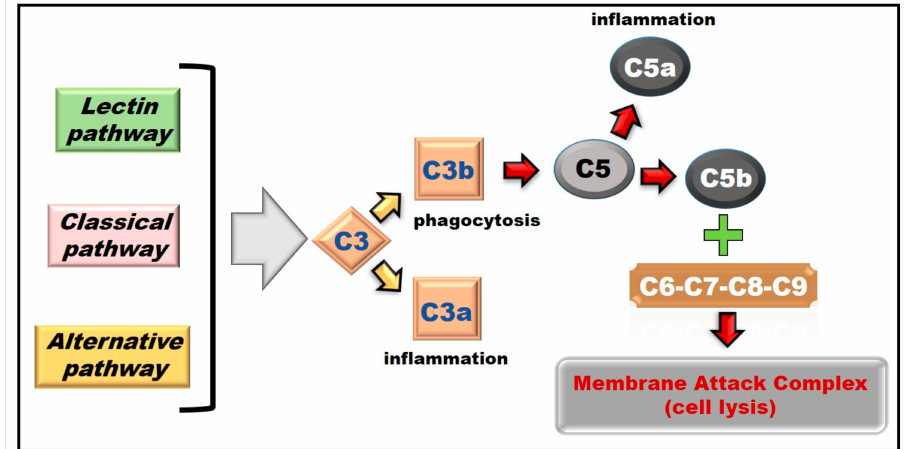
Figure 3. Overview of the complement system. Complement activation can be initiated by three distinct pathways: the classical, lectin and alternative pathways. Although each one is activated in response to di ff erent molecules, all of them manage to activate complement factors (C3 and C5) and promote the release of anaphylatoxins (C3a and C5a) associated with inflammatory processes. Complement activation ends with the membrane attack complex (MAC; C5b–C9) formation which can then cause targeted cell